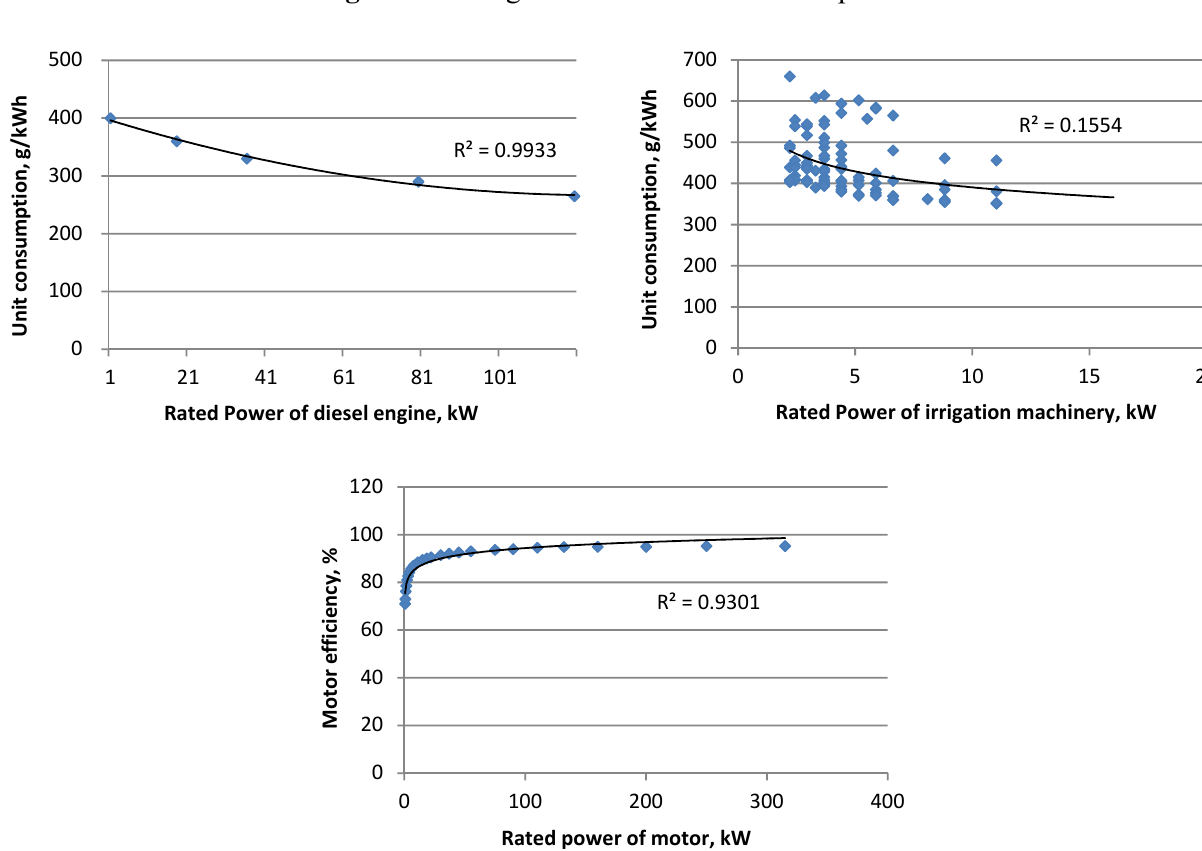
Figure 3. Fitting curves of the unit